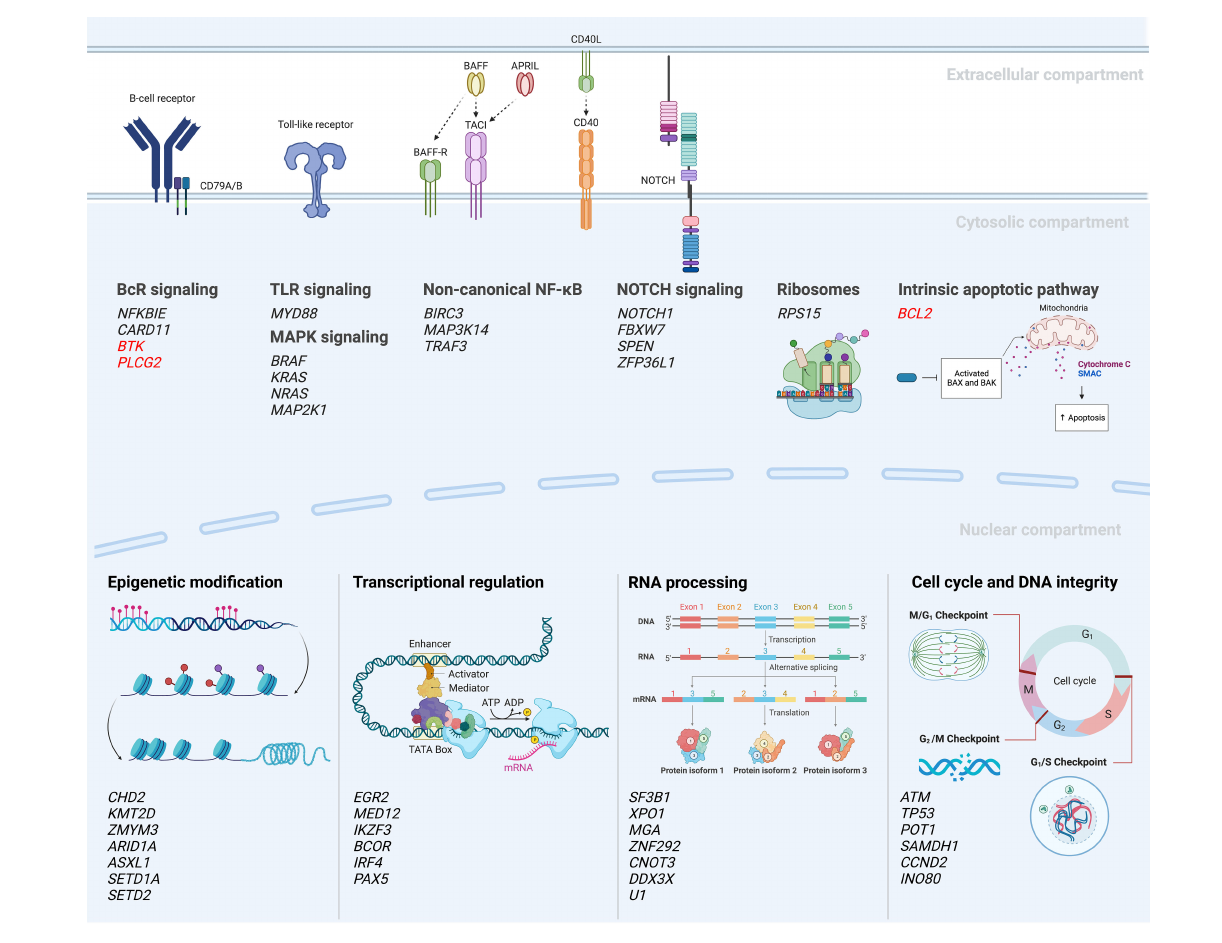
FIGURE 3 Mutational landscape and deregulated signaling pathways in CLL (18, 27, 30, 32 – 37). A selection of recurrently mutated genes are included; genes in red indicate mutations emerging during or after targeted